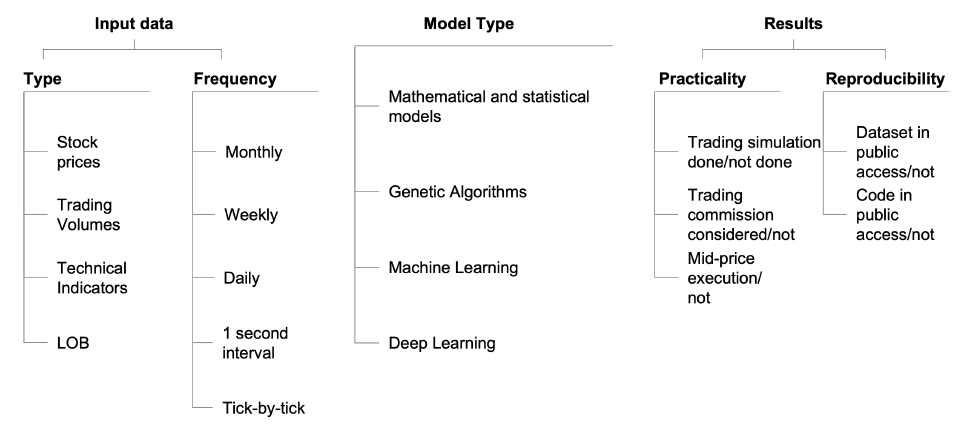
Figure 1. The reviewed papers